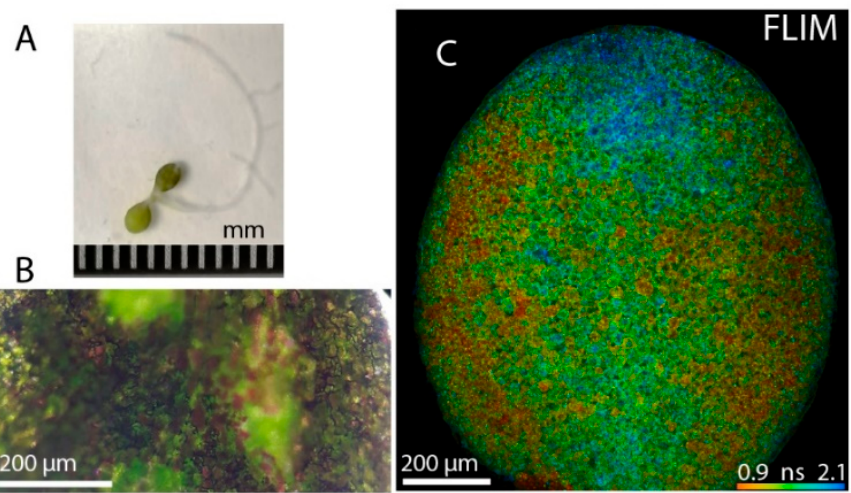
Figure 3. Arabidopsis cotyledons and fluorescence lifetime imaging microscopy (FLIM). ( A ) Photo- graph of an Arabidopsis seedling showing anthocyanin accumulation in its cotyledons. The scale is 1 mm ( B ) A zoomed-in photograph of the cotyledon lower epidermis shows cells with different amounts of anthocyanins (purple shade). ( C ) FLIM image of the cotyledon lower epidermis, where single epidermal cells can be distinguished. The lower lifetimes (red color) correspond to anthocy- anins. The scale bar is 200 micrometers, and the FLIM color bar is set for the mean lifetime image from 0.9 ns to 2.1 ns extracted from a multiexponential fit of the data.